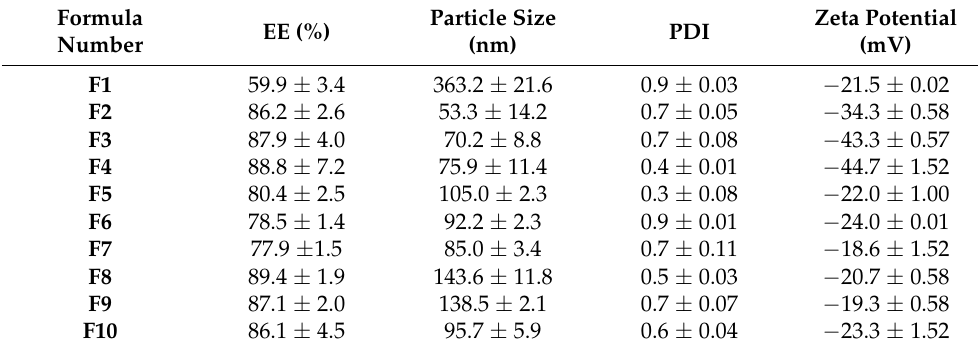
Table 3. Entrapment efficiency, particle size, PDI, and zeta potential values for the prepared Formula- tions of CXB-ES and CXB-TES ( n = 3 ±